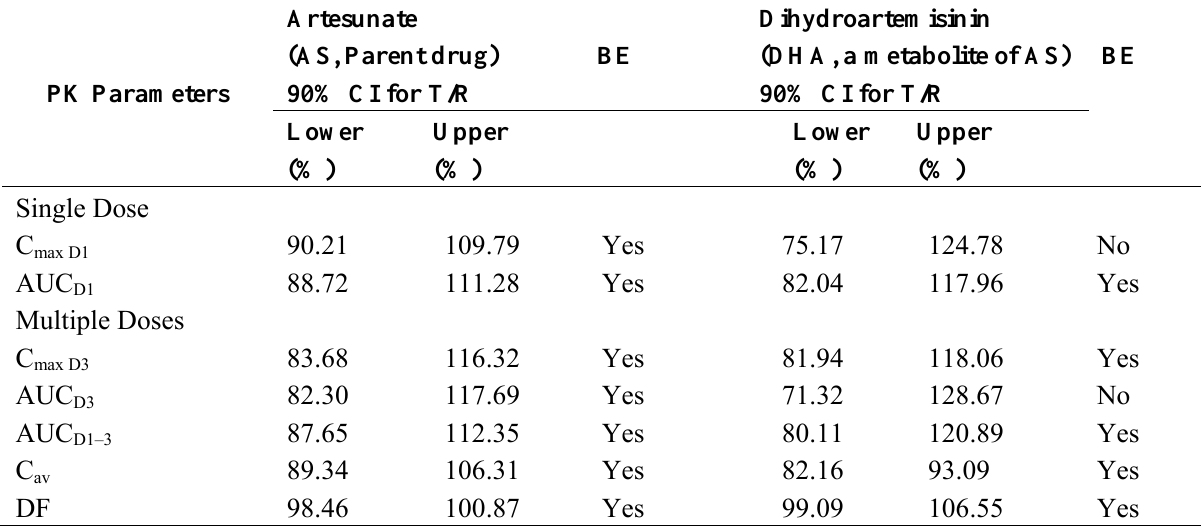
, C , AUC max D1 max D3 D1